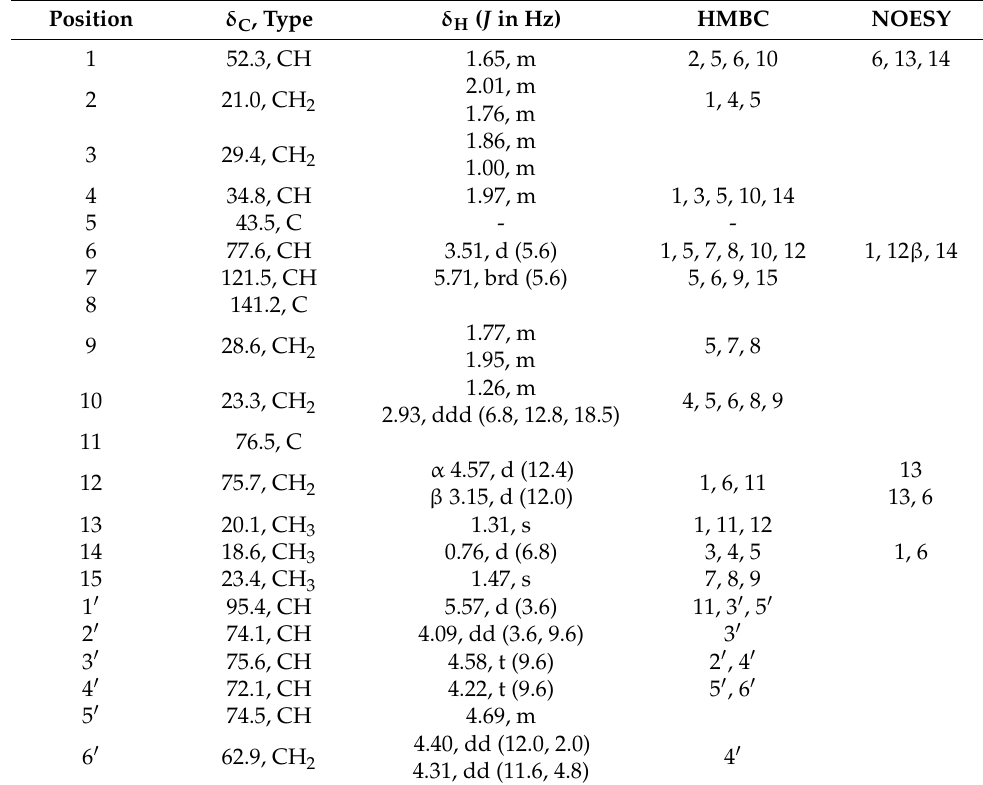
Table 2. NMR spectroscopic data (400 MHz, pyridine- d 5 ) for compound 2 .